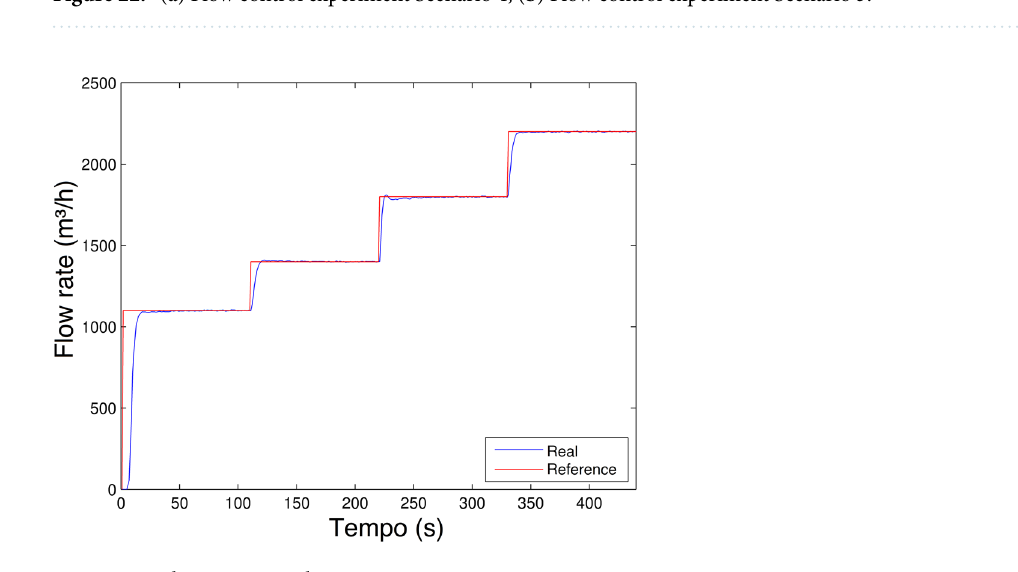
Figure 22. ( a ) Flow control experiment Scenario 4; ( b ) Flow control experiment Scenario 5.